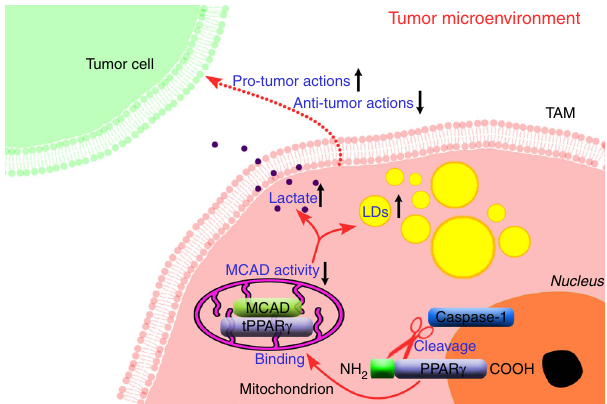
Fig. 10 Schematic summary. In the current study, we provided novel insights into the mechanisms underlying TAM differentiation and demonstrated that caspase-1 activity increases during TAM differentiation, and that caspase-1 cleaves PPAR γ at Asp64 and generates a 41 kDa fragment, this truncated PPAR γ translocates to mitochondria and inactivates MCAD. MCAD inhibition causes lipid droplets (LDs) accumulation in TAMs and enhanced lactate secretion, MCAD activity and metabolic reprogramming are highly correlated with pro-tumor action of TAMs ( up arrow for increase, down arrow for